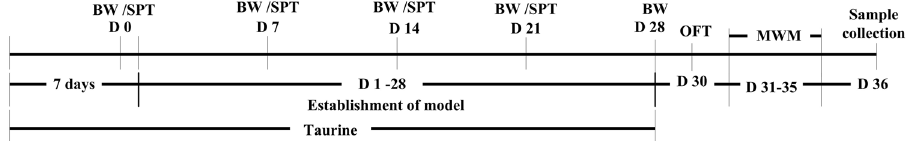
Figure 8. Experimental design. BW: body weight; SPT: sucrose preference test; OFT: open field test; MWM: Morris water maze. Rats were exposed to chronic unpredictable mild stress form day 1 to day 28. Taurine